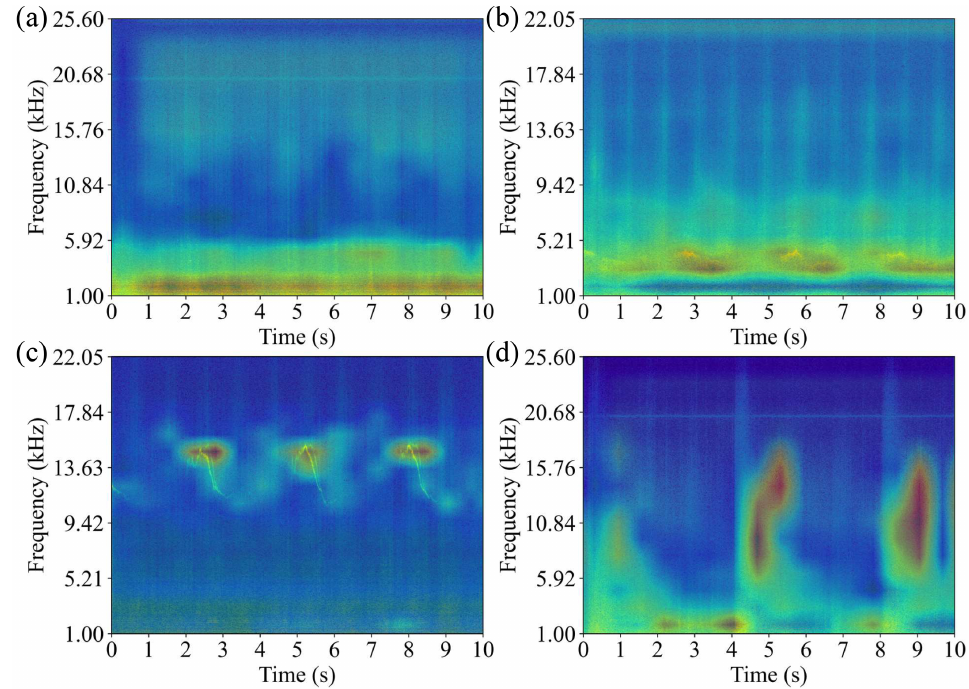
Figure 8. Class activation mapping for: ( a ) Normal (CUBE, Dawu); ( b ) Defect 1 (DR-60D, Dawu); ( c ) Defect 2 (DR-60D, Dawu); and ( d ) Defect 3 (CUBE,